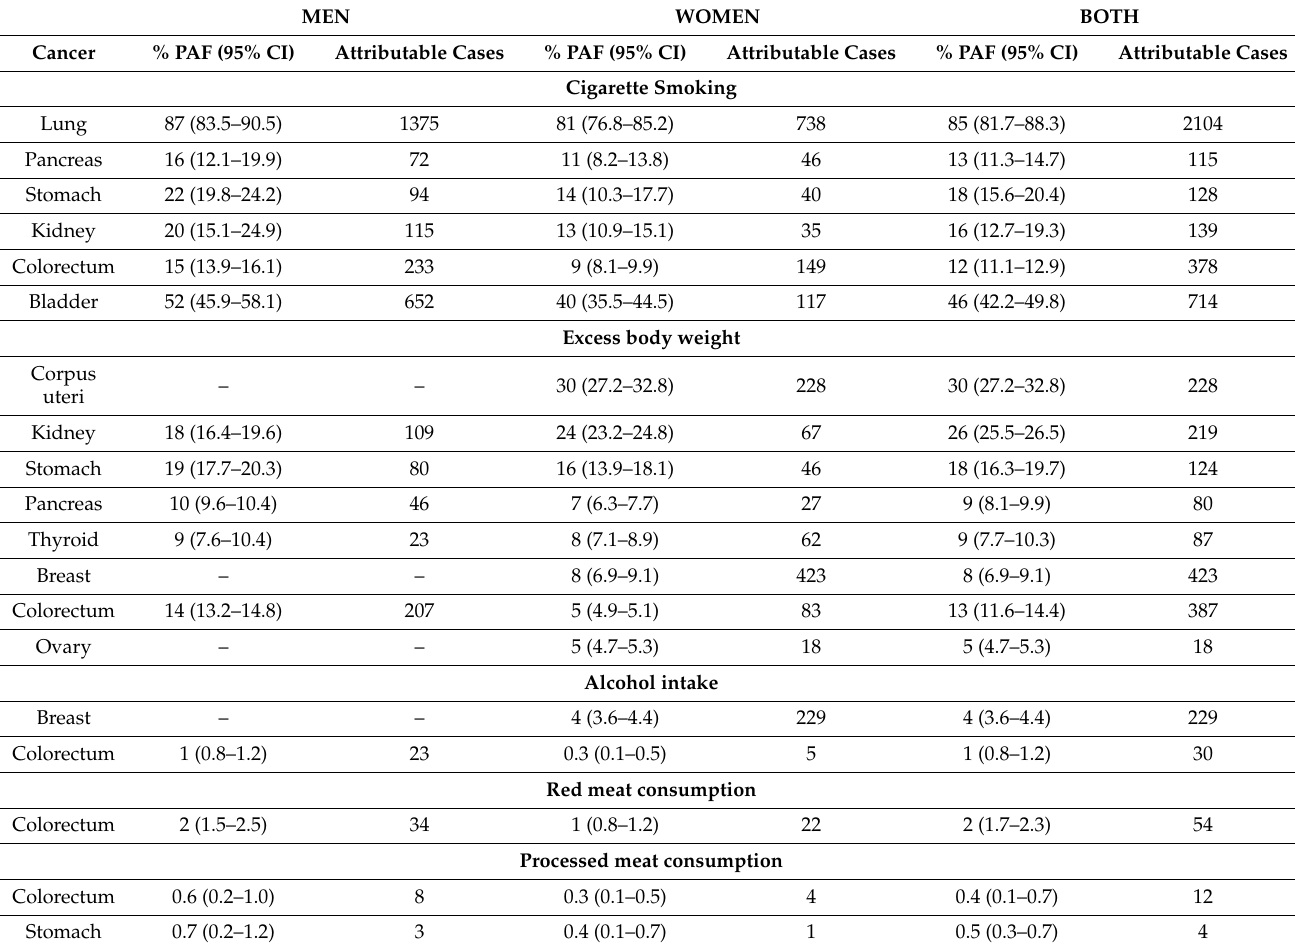
Table 2. Estimates cancer cases in adults aged 30 years and older in Israel in 2015 attributable to potentially modifiable risk factors by sex, risk factor, and cancer type, compared to the US.